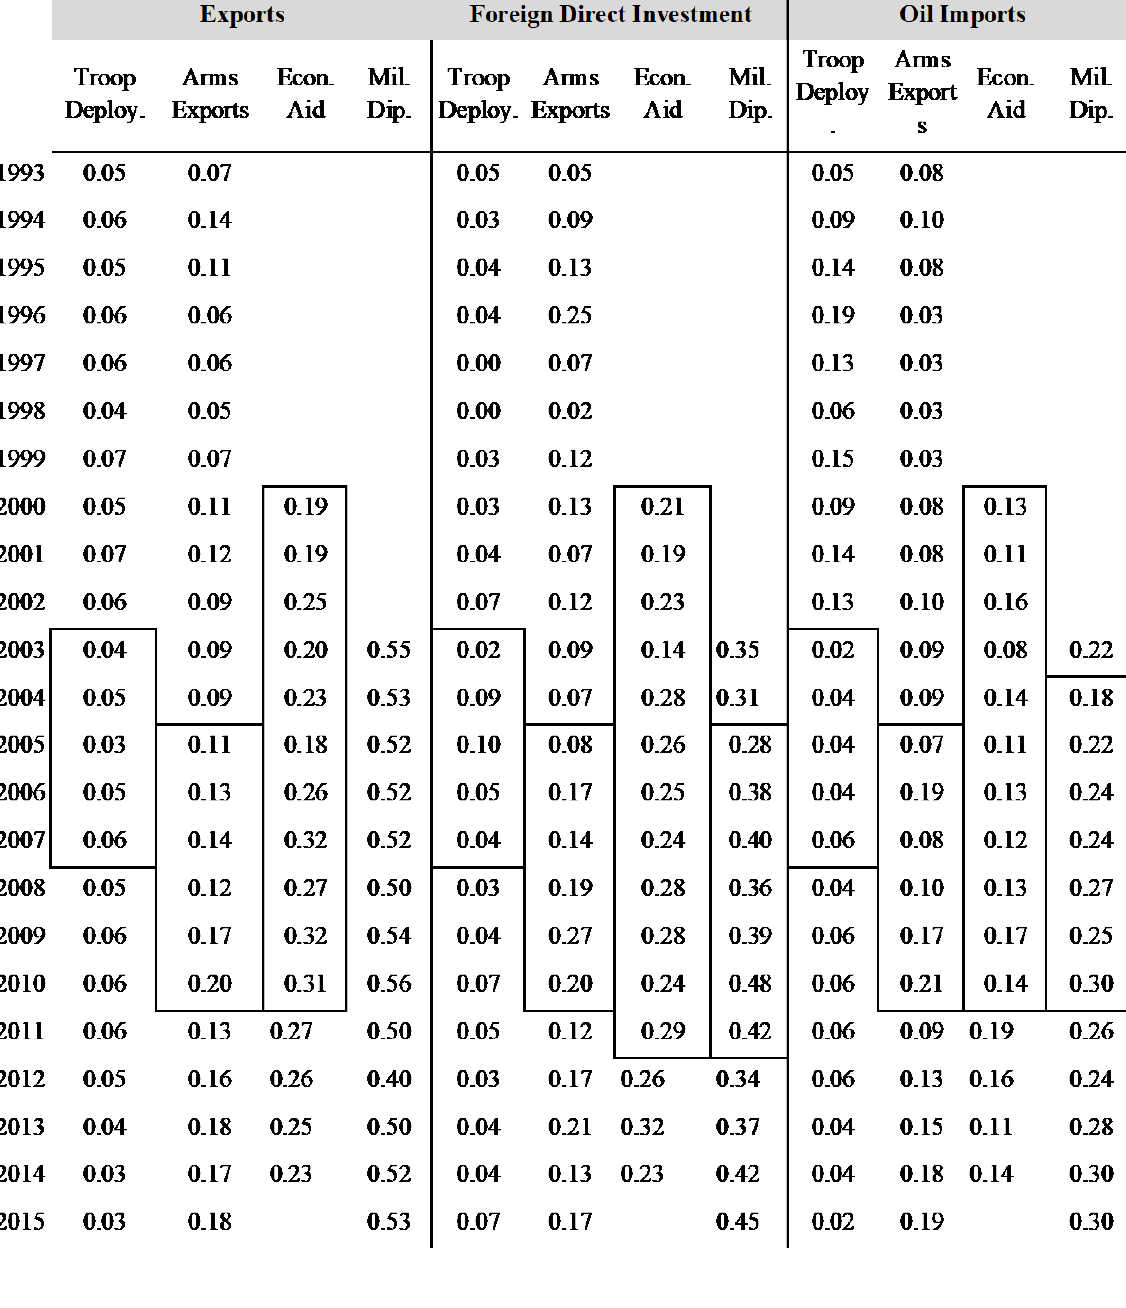
Table 2a: Jaccard Index, Economic and Political-Military networks (China, 1993 - 2015. "Key years of political-military network growth